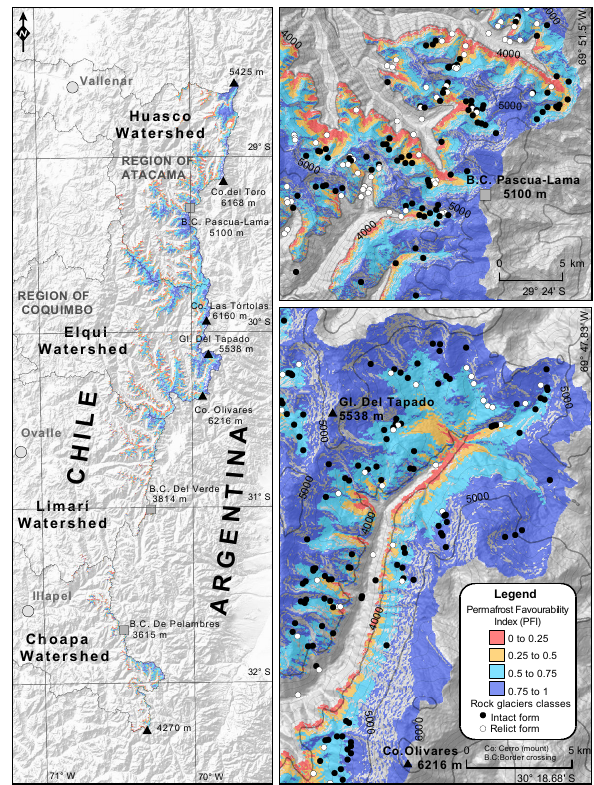
Figure 5. Permafrost favourability index (PFI) map of the semi- arid Chilean Andes based on the permafrost distribution model for debris